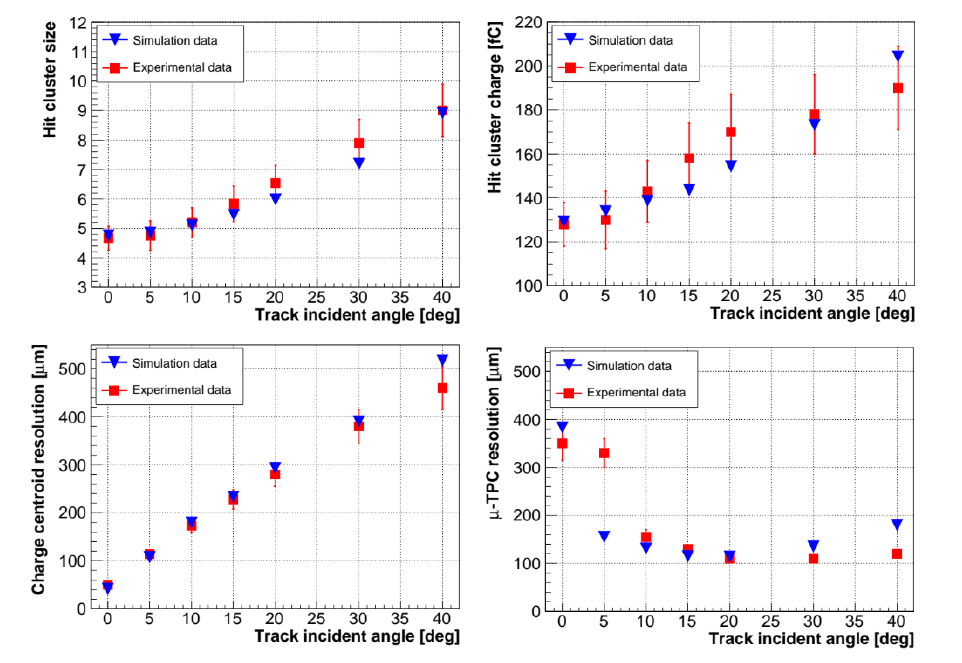
Figure 5: Experimental and simulated results for the four sentinel variables as a function of the incident angle: cluster charge (top left), cluster size (top right), CC resolution (bottom left) and µ TPC (bottom right). The tuning values have been already applied in the shown set of